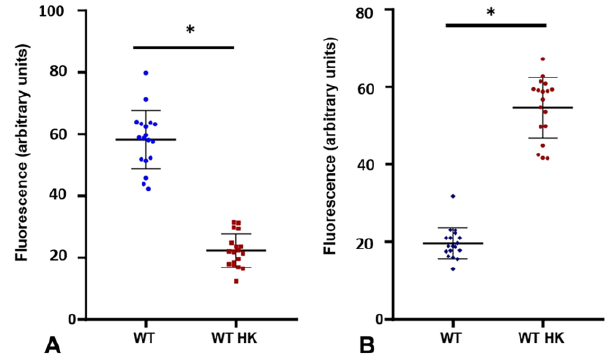
Figure 5. Exposure of mannan and chitin in C. albicans yeasts. From the images acquired from ConA-FITC ( A ) and WGA-FITC ( B ) staining experiments. The exposure of ( A ) mannan in live (blue dots) and heat-innactivated (HK, red squares) wild type (WT) cells, as well as the ( B ) chitin in live (purple diamonds) and heat-inactivated (HK, red dots) wild type (WT) cells, was calculated based on the fluorescence that the cells exhibit. The graph (mean ± SD) shows the fluorescence results of 20 different images for each treatment (* p < 0.0001).